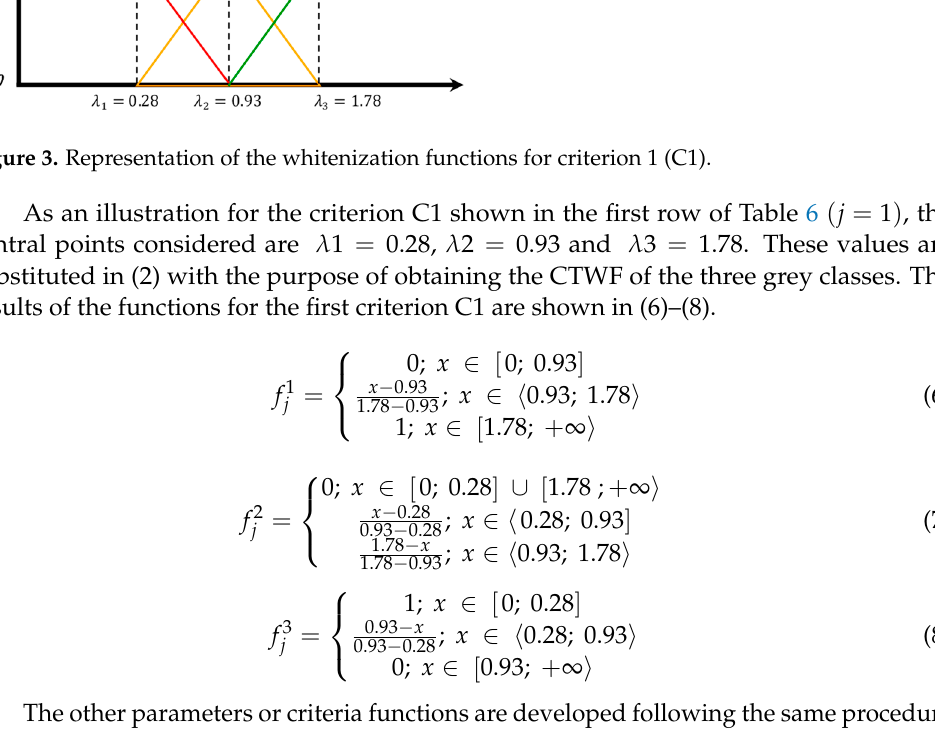
Table 8. Values of the functions evaluated in the groups.